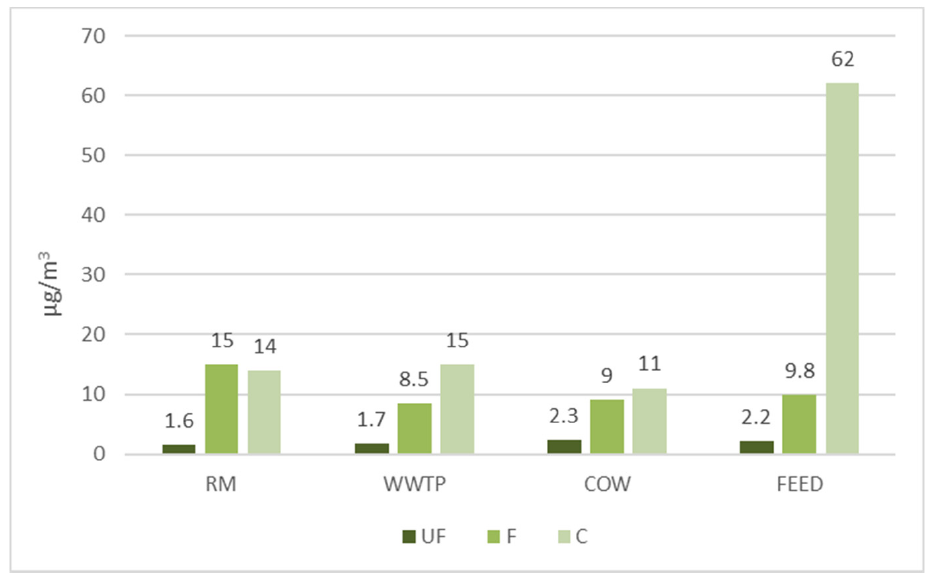
Figure 2. Mass concentration of ultrafine (UF), fine (F) and coarse (C) airborne particles in the urban site (RM) and in the three workplaces (WWTP: Wastewater treatment plant. COW: Shed site. FEED: Feed site).